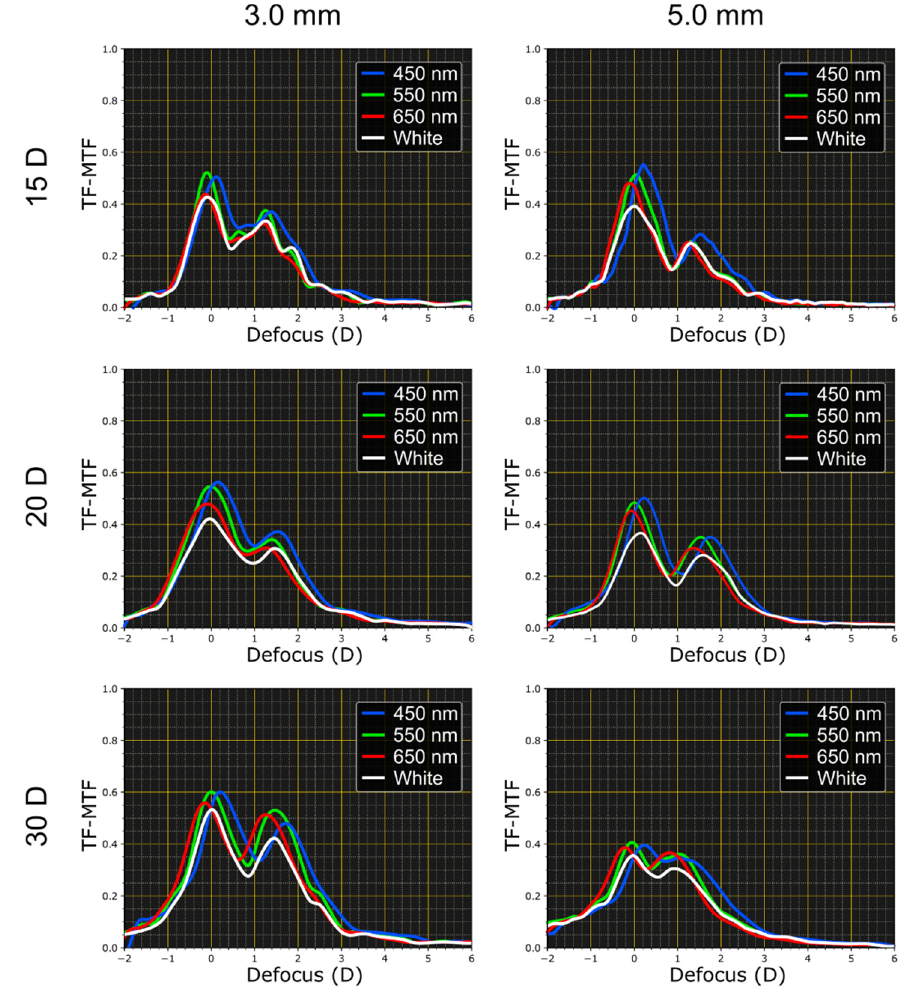
Figure 4. Polychromatic TF-MTFs of Femtis Comfort lenses of different base power. Table 1. LCA (D) of Femtis Comfort IOLs measured at the far and distance foci. Base Power